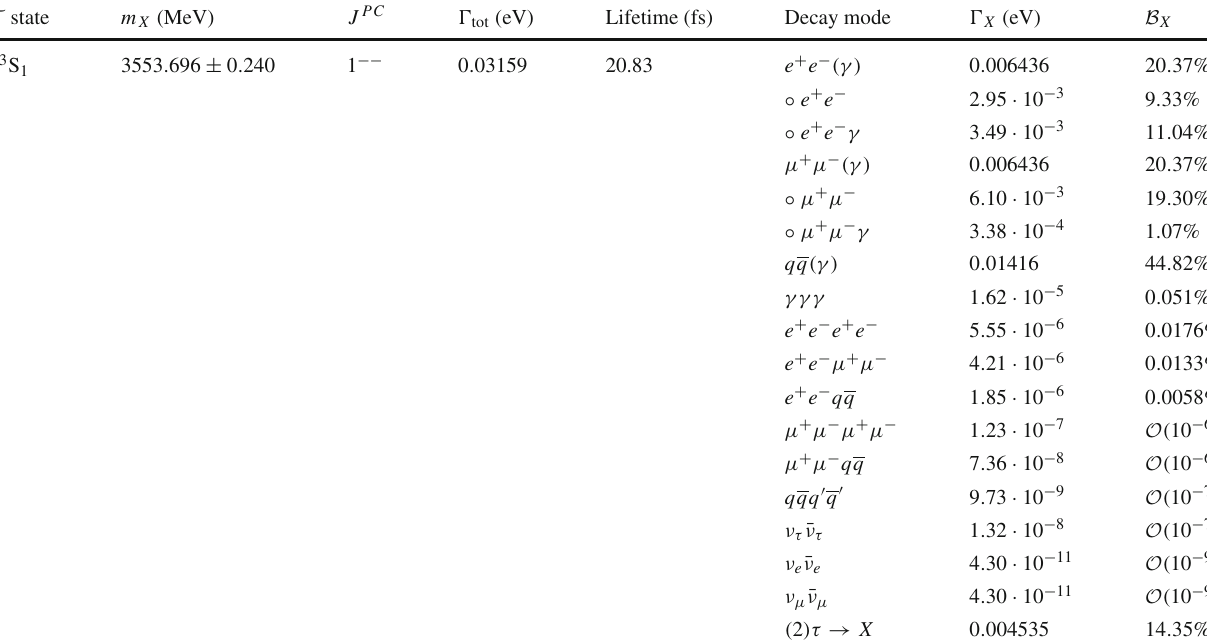
(cid:3) + (cid:3) − (γ) have been also broken-down into the exclusive modes (cid:3) + (cid:3) − and (cid:3) + (cid:3) − γ (where the latter require threshold photon energies E thr γ > m e ,μ for the dielectron and dimuon channels, respectively, see text for details)